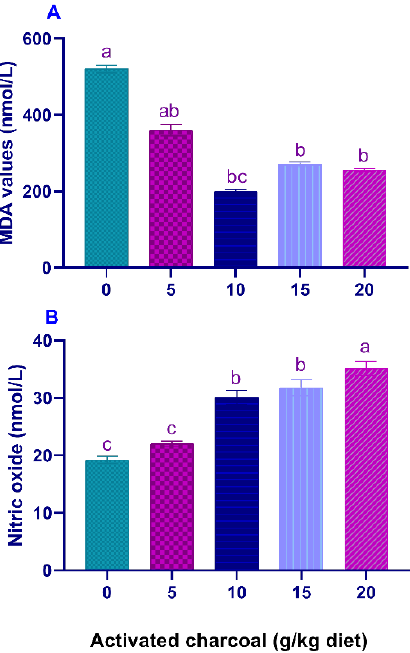
Figure 2. Serum malondialdehyde (MDA) ( A ) and nitric oxide (NO) levels ( B ) of Nile tilapia fed diets supplemented with graded, activated charcoal (AC) levels for 8 weeks. (a, b, c) indicate sig- nificant differences between groups.